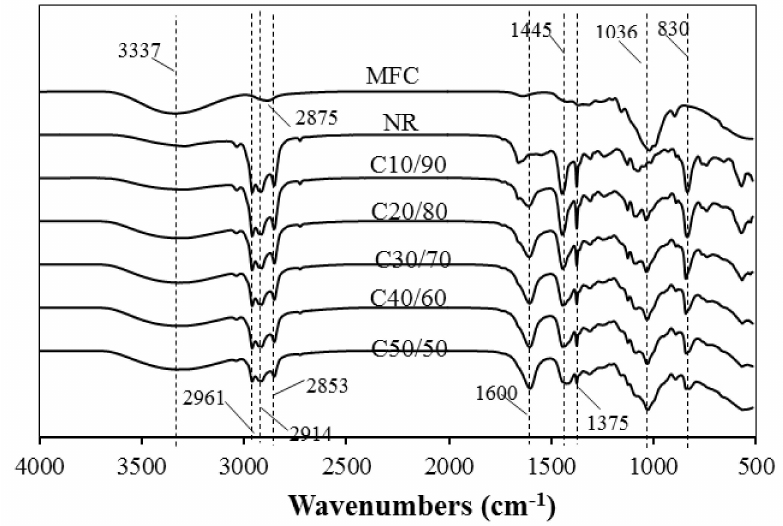
Figure 4. FTIR spectra of MFC, NR, and MFC–NR